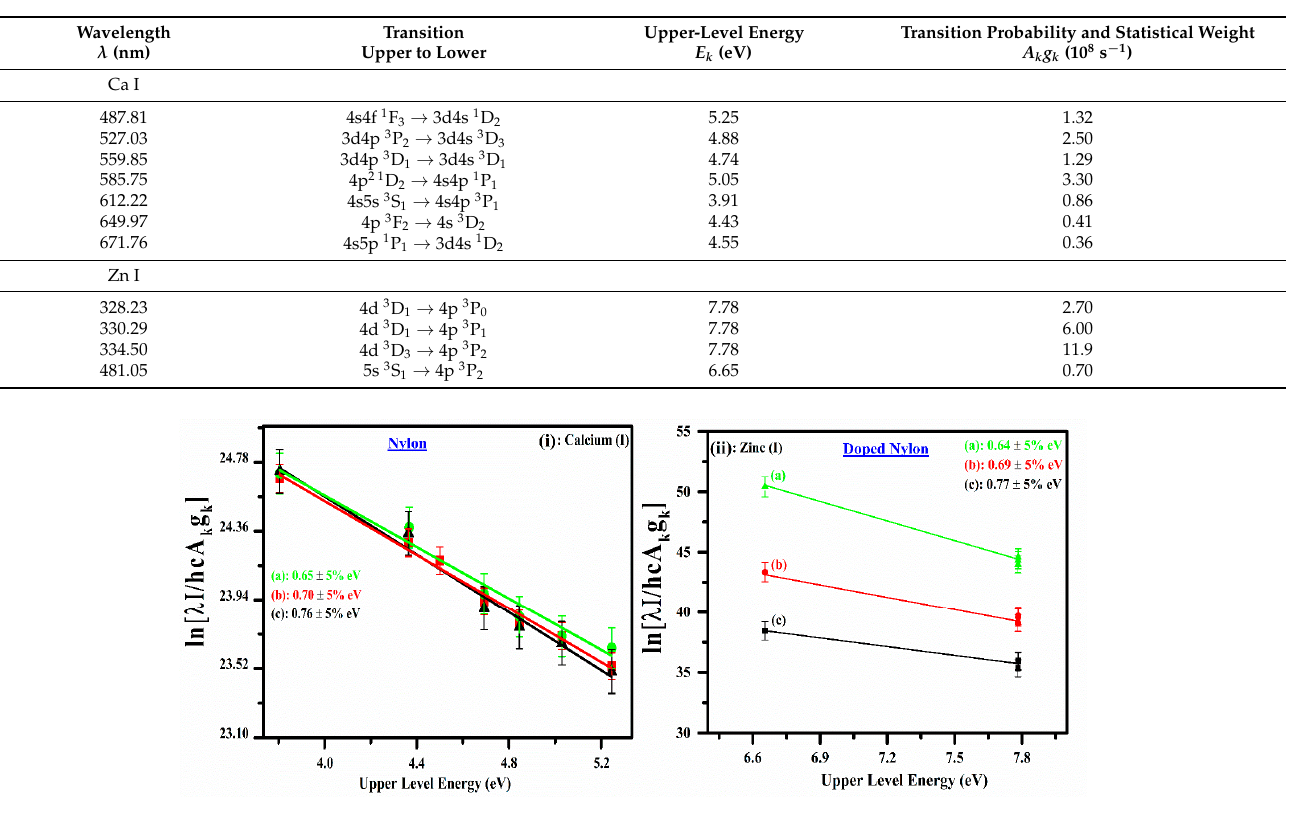
Figure 5. ( i ) Temperature Boltzmann plots for the pure organic nylon drawn using five neutral calcium (Ca I) emission lines. ( ii ) Boltzmann plots for the co-doped nylon made using zinc optically thin emission lines. The full width at a half area ( FWHA ) is calculated using a hydrogen H α spectral emis- sion line profile at 656.28 nm as demonstrated in Figure 6, displaying the experimentally analyzed line profile (blue color) corresponding to FWHA yielding as (0.99 ± 0.05) nm. The simplest formula for the scheming of electron number density using the H α line is given as [40,41]: